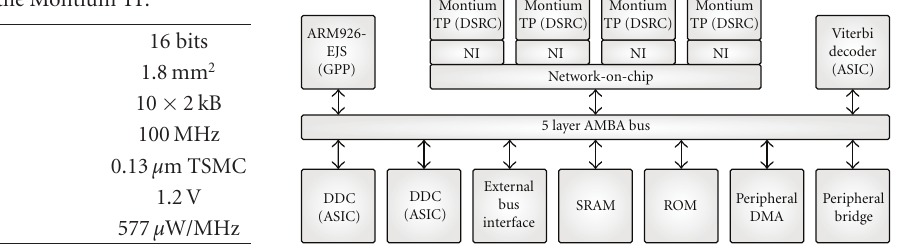
Figure 5: Annabelle SoC block